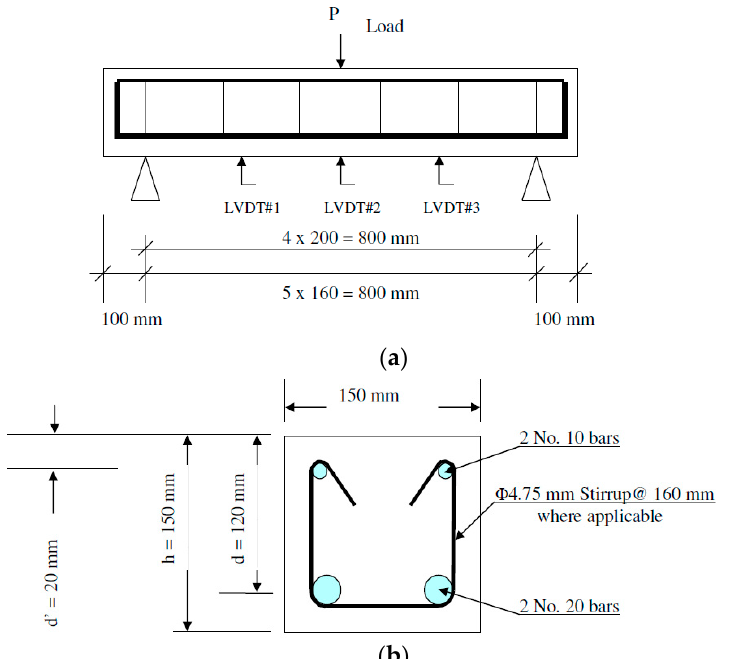
Figure 1. Reinforced concrete (RC) beams tested under quasi-static loading: ( a ) elevation; ( b ) cross-section [22]. Table 1. Characteristics of reinforced concrete beams.